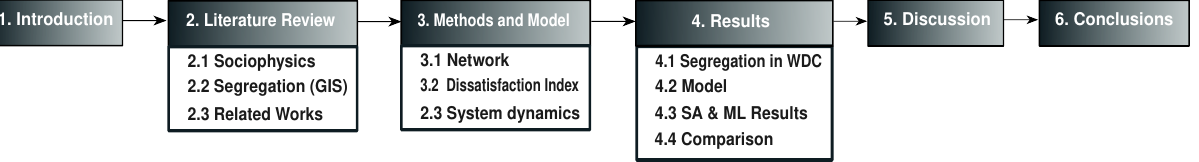
Figure 1. Scheme of the paper organization. WDC, SA, and ML are the abbreviations of Washington D.C, Spatial Analysis, and Machine Learning,